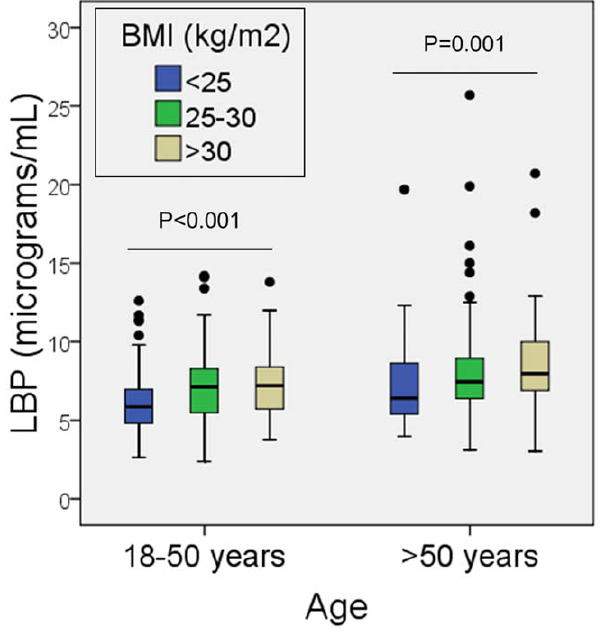
Figure 3. Serum concentrations of lipopolysaccharide-binding protein (LBP) according to age strata and body mass index (BMI). Horizontal lines represent median values, boxes represent the interquartile range, whiskers represent the range, and dots represent extreme values (higher than the 75 th percentile plus 1.5 times the interquartile range). P-values we obtained with the Jonkheere-Terpstra test for trend.